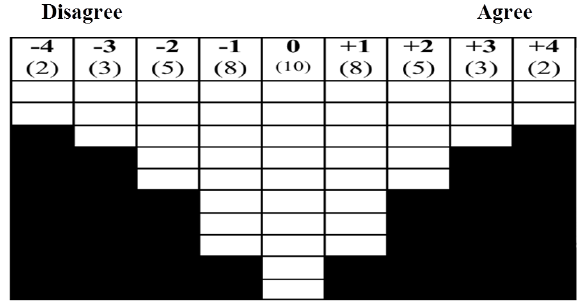
Figure 2. The fixed distribution used in this study. The participant places the two statements that he agrees most with in the + 4 col- umn, the next three statements in the + 3 column, etc. The process is repeated for the disagree